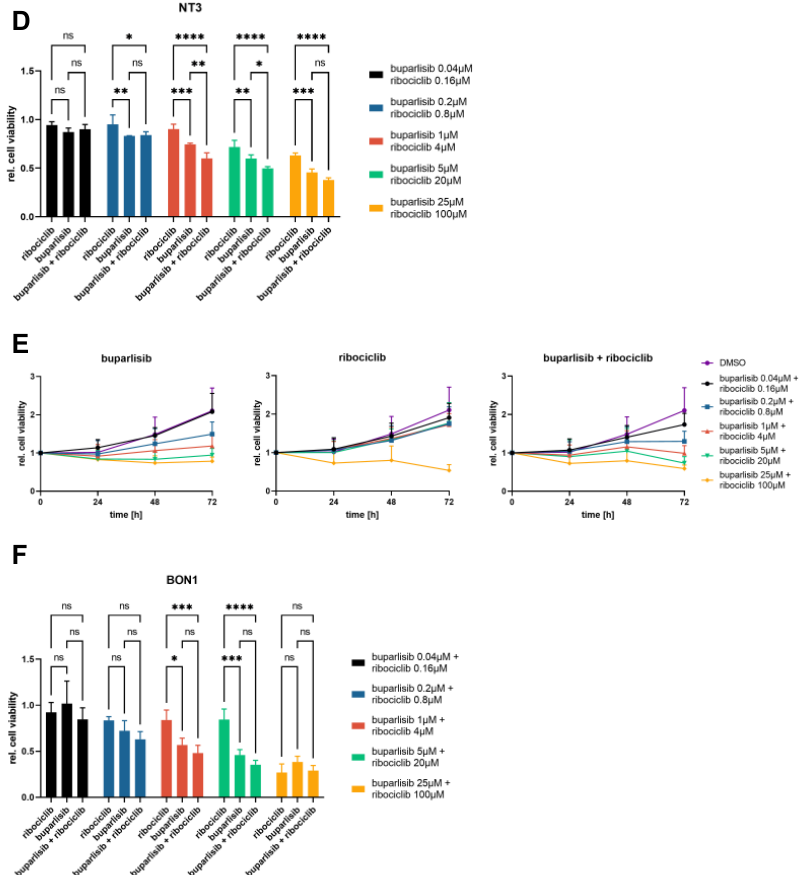
Figure 5. Effect of buparlisib and ribociclib on cell viability of INS-1E, NT-3 and BON-1 PanNET cells in 3D culture. ( A , C , E ) Cell viability of 3D spheroids of INS-1E ( A ), NT-3 ( C ) and BON-1 ( E ) cells upon treatment with buparlisib, ribociclib, their combination or DMSO vehicle control. A range of concentrations was used to evaluate the effect of the drugs at 24 h, 48 h, 72 h post-treatment. ( B , D , F ) Relative cell viability of 3D spheroids of INS-1E ( B ), NT-3 ( D ) and BON-1 ( F ) cells at the 72 h timepoint normalized to time 0 and to the DMSO control. Data shows the mean ± SD from three independent experiments with eight technical replicates each. ns, not significant; *, p < 0.05; **, p < 0.01; ***, p < 0.001; ****, p < 0.0001 (by 2way